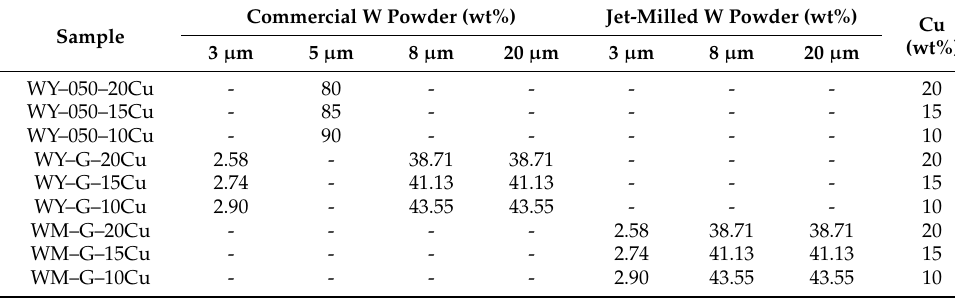
Table 1. Mass ratio of different W powders in the